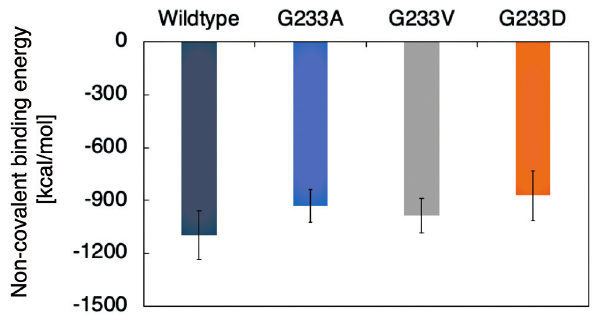
Fig. 3 Noncovalent binding energy generated between VWFand wild type, G233A, G233V, and G233D mutant of GPIb ɑ . The means and standard deviations of noncovalent binding energy generated be- tween VWF and GPIb ɑ at wild-type ( dark purple ), G233A ( light blue ), G233V ( gray ), and G233D ( orange ) are shown in kcal/mol.